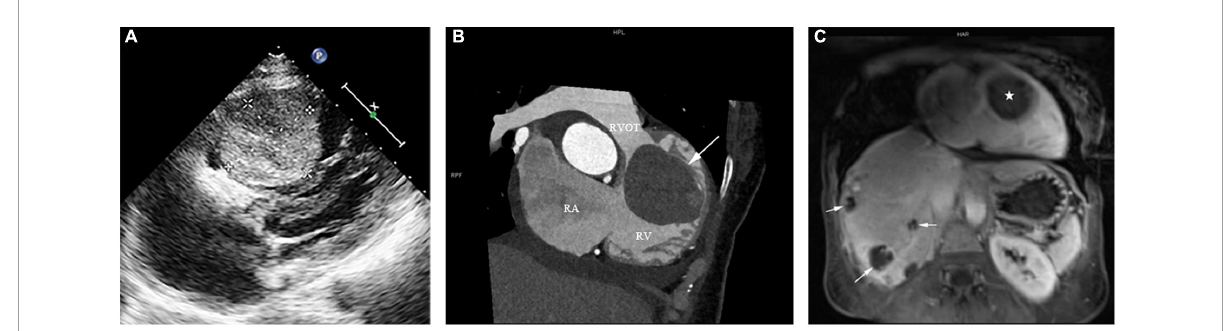
FIGURE1 (A) Preoperative transthoracic echocardiography showing a large mass measuring 4.82 cm × 4.48 cm × 6.42 cm attached to the anterior wall of the right ventricle, with a moderate to strong and relatively homogeneous echo. (B) The computed tomography scan of the patient’s chest showing a right ventricular mass (arrow) in the right ventricular outflow tract (RVOT). RA: right atrium; RV: right ventricle. (C) Reconstructed magnetic resonance imaging of the patient’s chest and abdomen showed a cardiac mass concurrent with multiple hepatic lesions. The right ventricular mass and the multiple liver lesions are indicated by a star and three arrows, respectively.